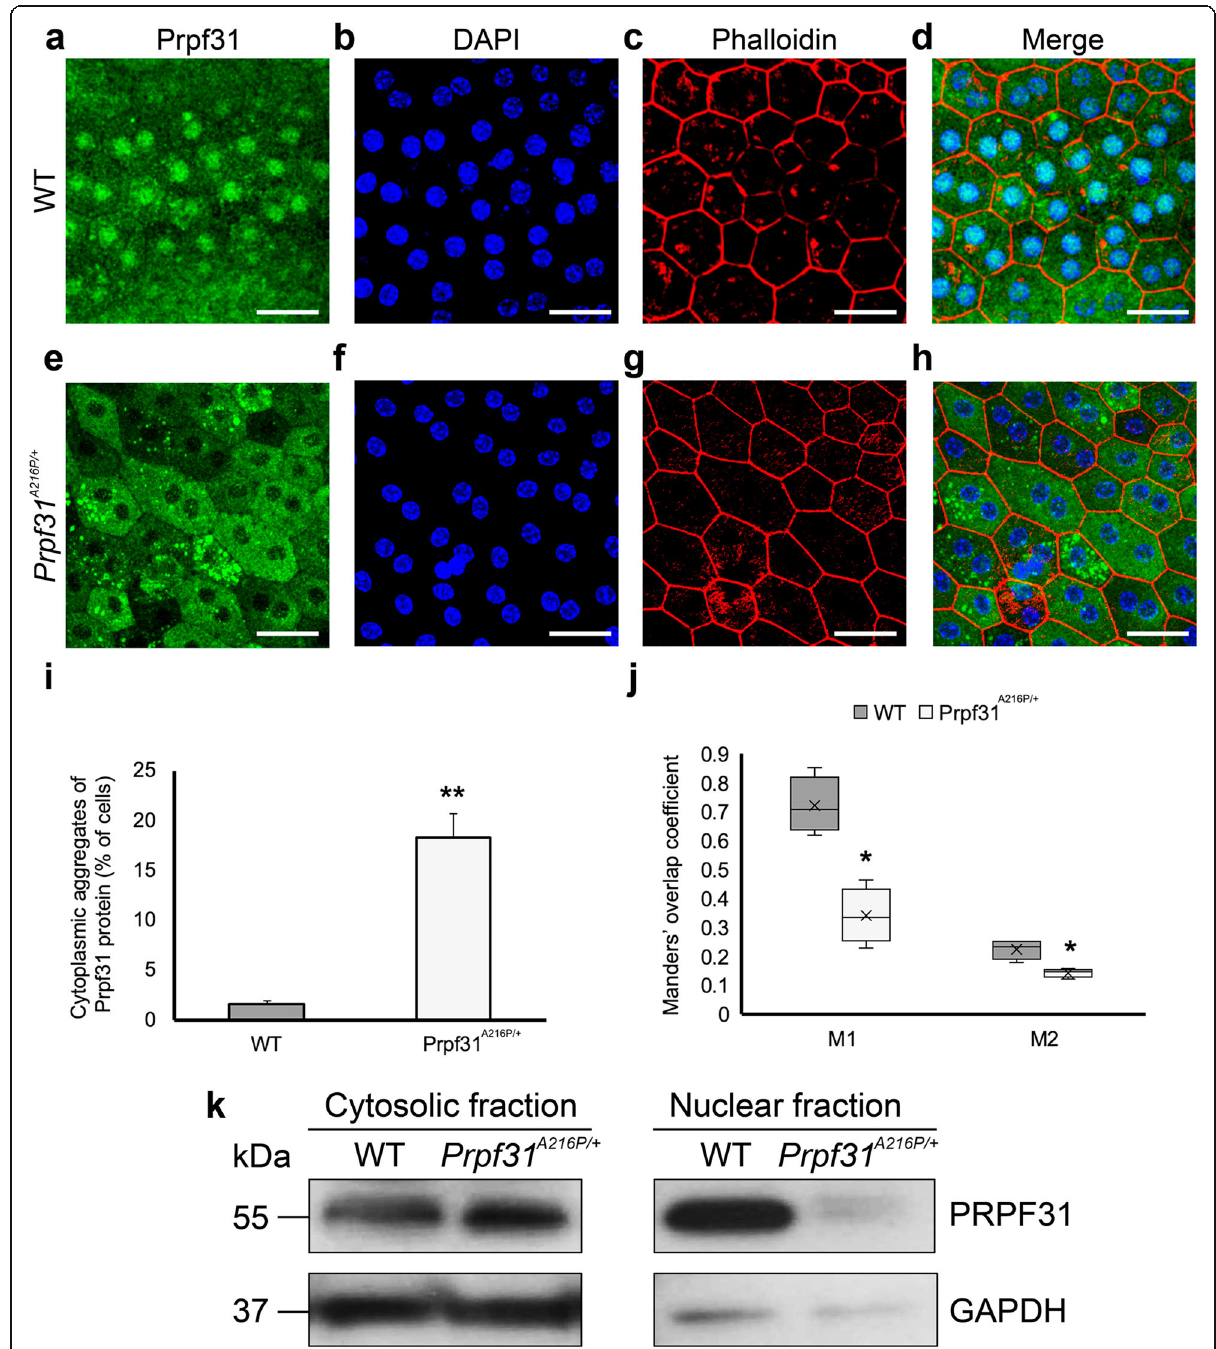
Fig. 3 Large cytoplasmic aggregates of Prpf31 protein were observed in the RPE of Prpf31 A216P/+ mice . Whole-mount of the RPE layer from WT ( a - d ) and Prpf31 A216P/+ mice ( e - h ) were immunostained with anti-Prpf31 antibodies ( a, e ). Cell nuclei were stained with DAPI ( b, f ), and TRITC- phalloidin was used to visualize the F-actin microfilaments ( c, g ). Prpf31 signal was mainly localized in the nuclei of WT RPE cells ( a ), while large protein aggregates stained for PRPF31 were observed in the cytoplasm of RPE cells of mutant Prpf31 A216P/+ mice ( e ). The bars in graph i represent the percentage of RPE cells with cytoplasmic aggregates of Prpf31 protein ± SEM in WT and Prpf31 A216P/+ whole mount RPE samples ( n = 1200 cells were counted from 4 mice in each group). The boxplot j represents the Manders ’ overlap coefficient of DAPI+Prpf31/DAPI colocalization (M1) and Prpf31+ DAPI/Prpf31 colocalization (M2) in WT and Prpf31 A216P/+ whole-mount RPE samples ( n = 4 in each group). Expression of Prpf31 protein was evaluated in the cytosolic and nuclear fractions by Western blot ( k ). Statistically significant differences were determined by t- test or Mann-Whitney U -test (* p < 0.01, ** p < 0.001). Scale bars represent 25 μ